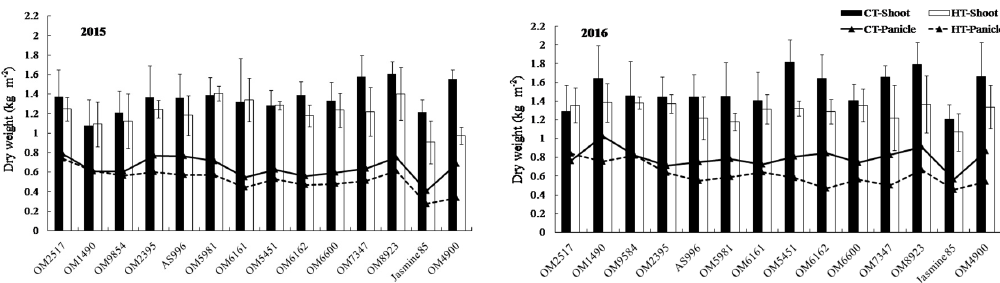
Figure 3. Dry mass production at the ripening stage under control and high temperature treatments of 14 Vietnamese cultivars in 2015 and 2016. Vertical bars indicate SD of means ( n = 4).